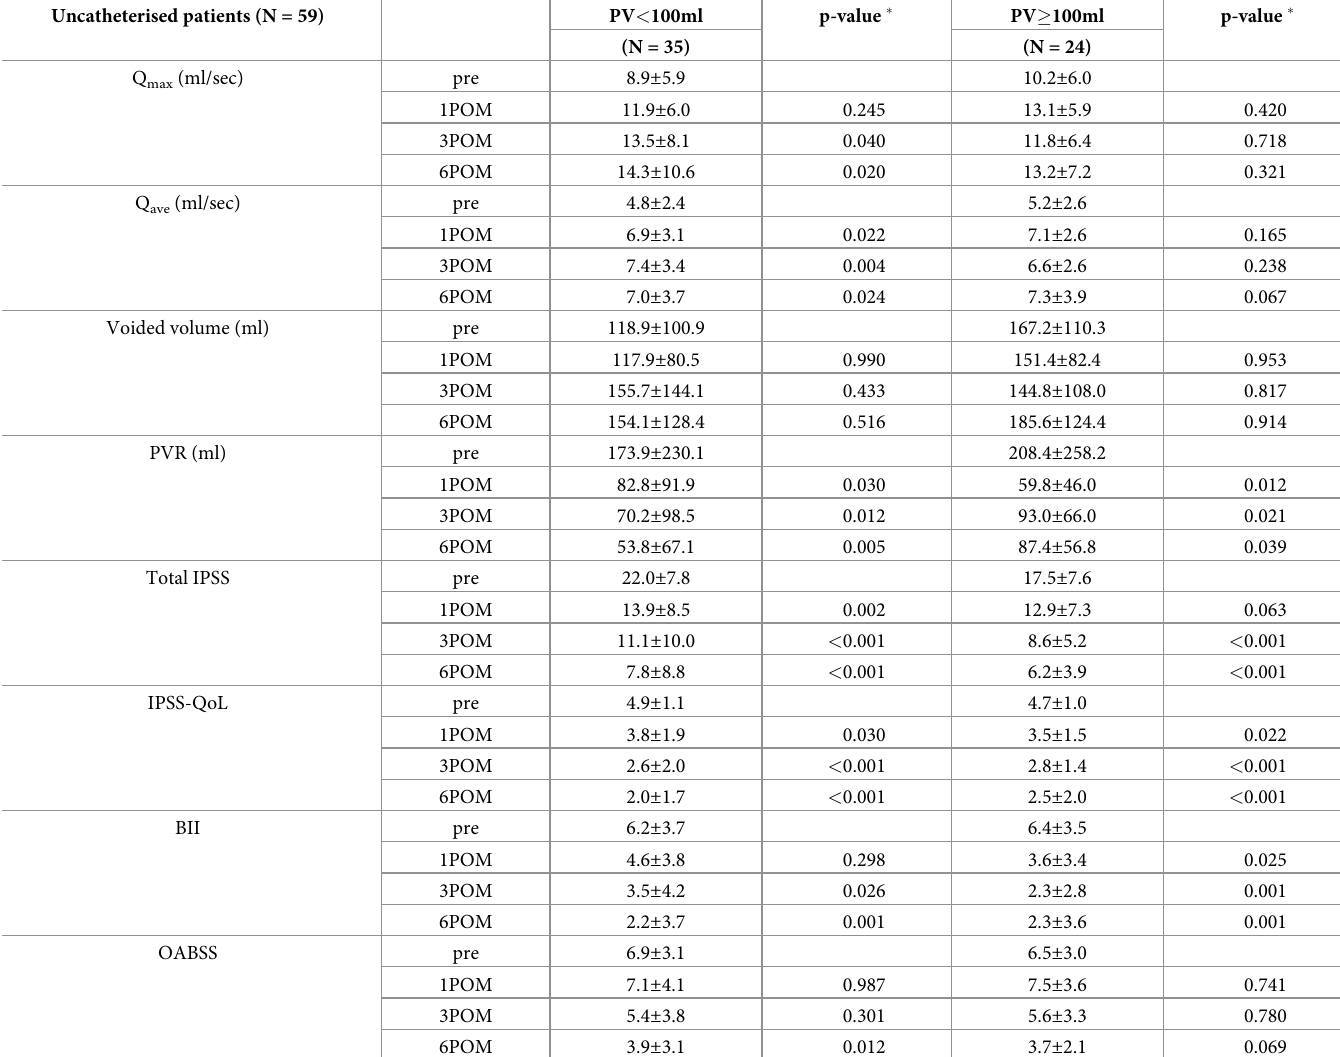
Table 3. Uroflowmetric parameters and patient report outcomes before and after B-TUVP of uncatheterised patients (N = 59). Uncatheterised patients (N =